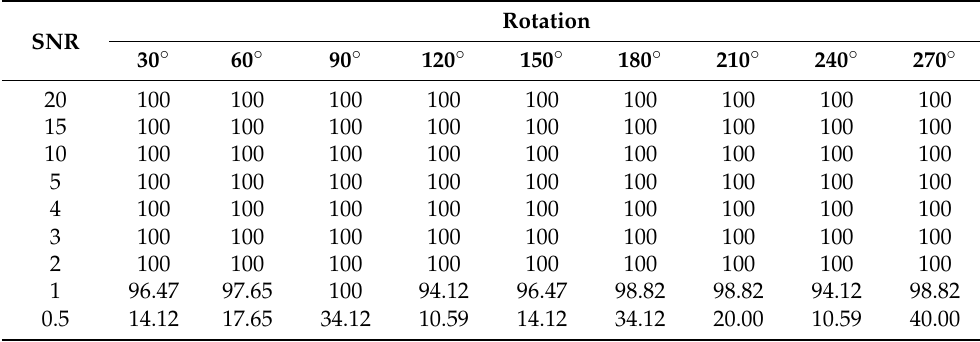
Table 7. The correct recognition rates for a combination of rotation angles and noise levels for the proposed method for the printed Chinese character dataset.